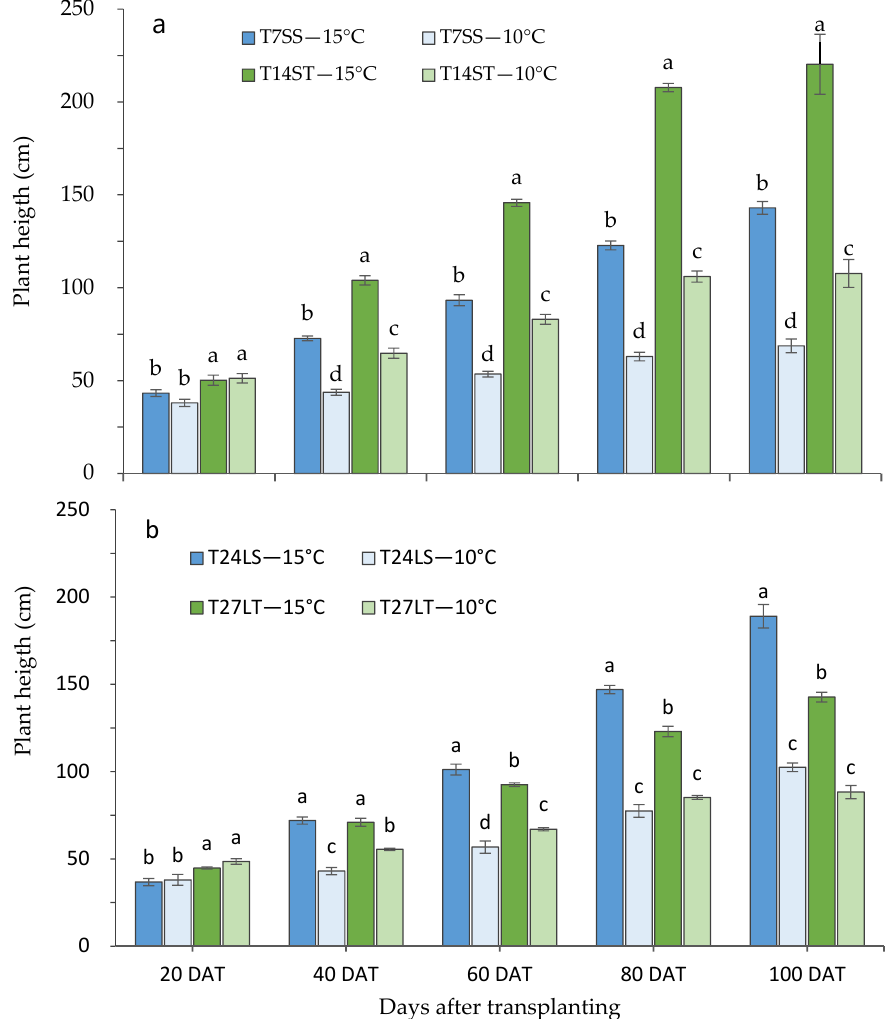
Figure 1. Changes in the average plant height of tomato accessions during entire growth period in 10 and 15 °C for cherry ( a ) and large fruit ( b ) type accessions. SS: small sensitive, ST: small tolerant, LS: large sensitive and LT: large tolerant. The vertical bars indicate the means ± SE (n = 4). Different letters above bars indicate a significant difference based on Duncan’s multiple range test ( p ≤ 0.05) among accessions in 10 and 15 °C within each number of days after transplanting.